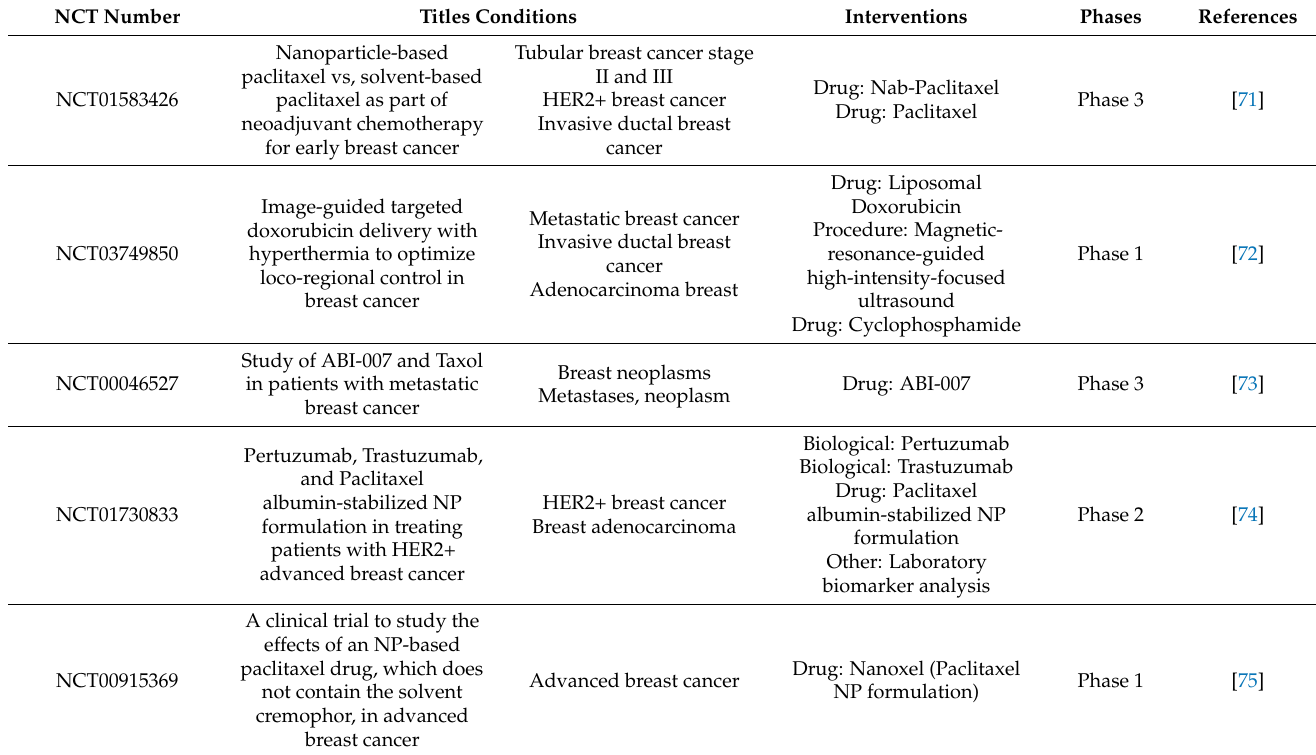
Table 4. Current clinical studies investigating nanomedicine to treat breast